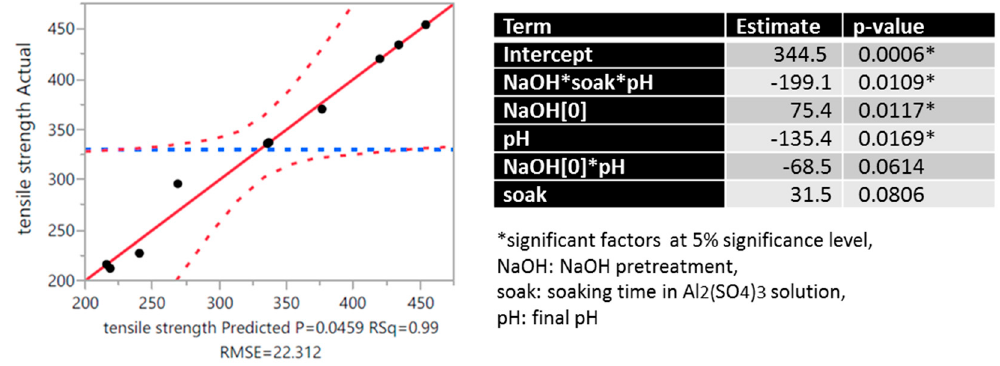
Figure 5. Actual vs. Predicted Plot (- - - - 0.05 significance curve; - - - - mean) for the regression model and the model coefficients.